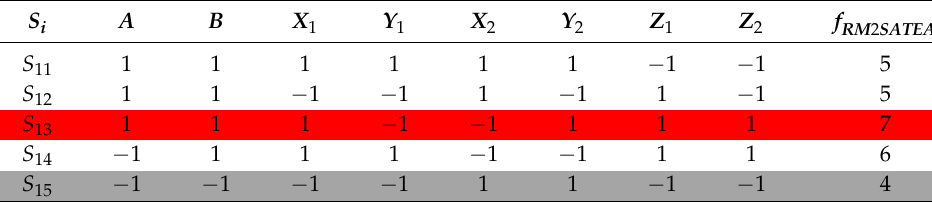
Table A11. Party 3 lost S 15 to Party 1.